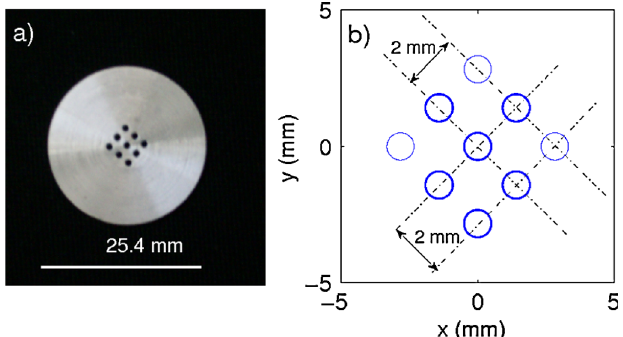
FIG. 2. (Color) Picture (a) of the aluminum mask used to shape the laser beam into a series of transversely separated beamlets and corresponding schematic of the mask geometry (b). In the experiments reported in this paper only five or six holes were not obstructed [shown as thicker line circles in (b)] and the mask was oriented to yield the pattern shown in (b) on the virtual photo- cathode [see also Fig. 4 (left image) for the corresponding uv laser transverse